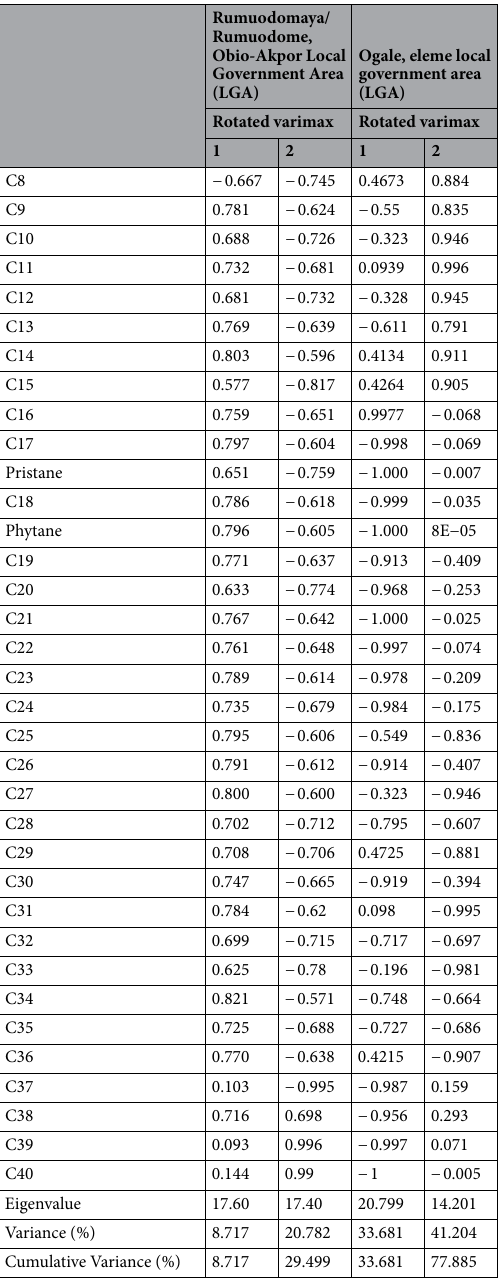
Table 5. Principal component analysis of mean concentration of TPHs in rainwater.